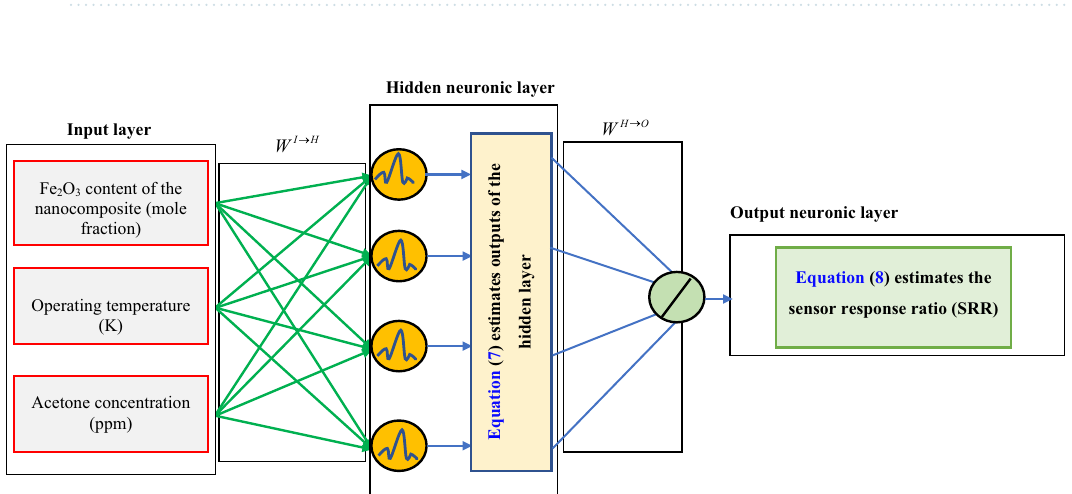
Figure 2. The general shape of the B-spline wavelet incorporated in the WT-ANN model.